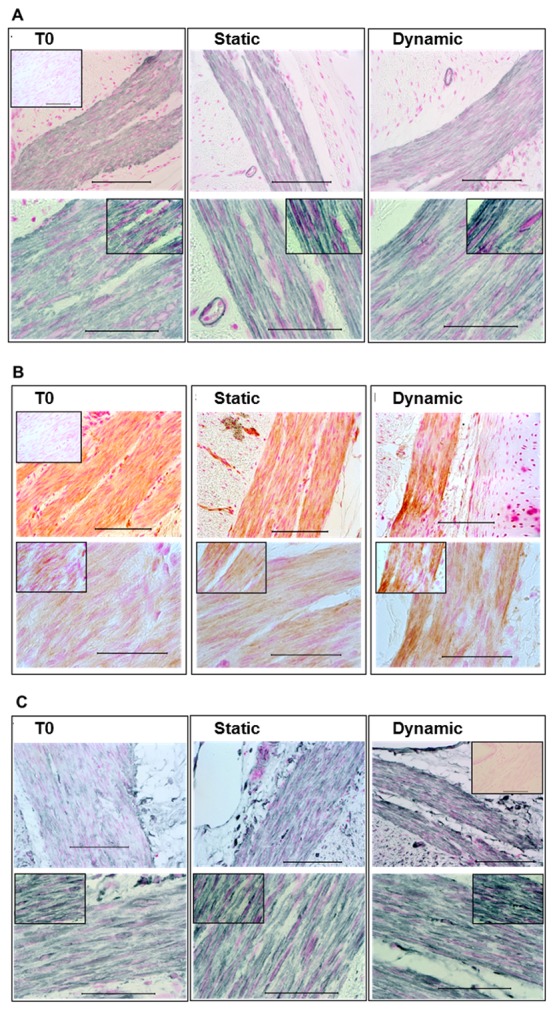
The subcellular structures of actin and microtubule are similar during static and dynamic loading. Immunohistochemistry (IHC) shows the distribution of ASMA (A), β-actin (B) and α-tubulin (C) on representative sections of bovine intact airways at time 0 (before stretch, T0) and after 90 min of static or dynamic Ptm loading conditions without constriction. β-actin represented as brown (B), ASMA, and α-tubulin are represented as blue (A and C) and nuclei as pink (A, B and C). The inset in the top rows shows the technical control for IHC and counterstained for nuclei. All conditions were processed simultaneously for each antibody (n = 30/condition). The insets in the bottom row are enhanced images for better cellular visualization. Scale bars are 100 µm on the top row sections and 50 µm on the bottom rows.